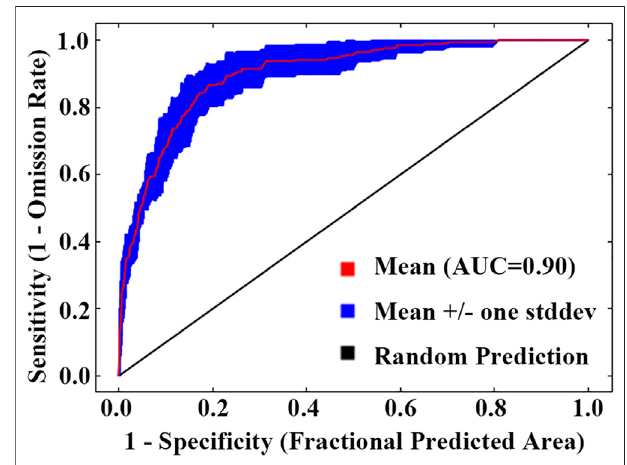
FIGURE 1 | ROC curves with error bars and average AUC across models (the red curve shows the mean of AUC of the Maxent model, the blue margins indicated the mean of +/ − one standard deviation of the Maxent model, and the black line shows the random prediction calculated in 10 replicates